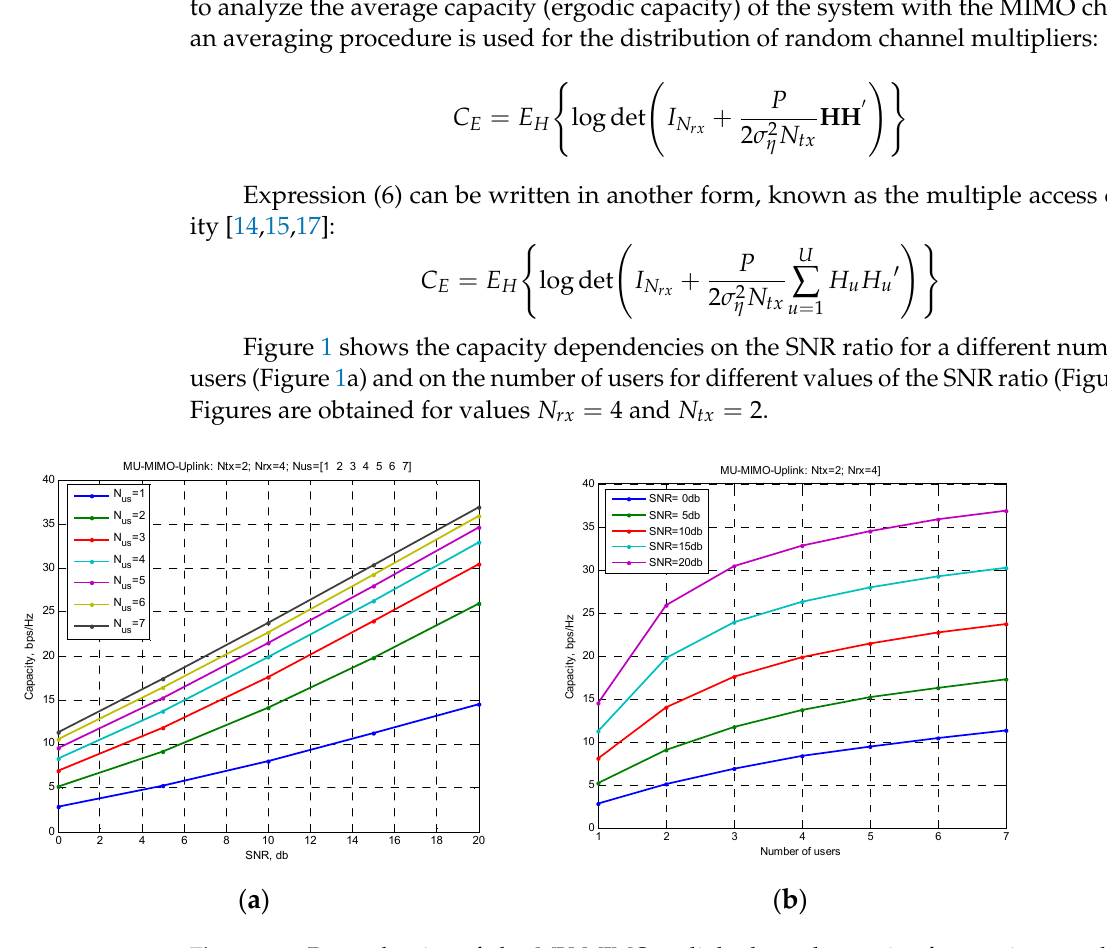
Figure 1. Dependencies of the MU-MIMO uplink channel capacity for continuous channel: ( a ) capacity dependencies on the SNR ratio for a different number of users, ( b ) capacity depen- dencies on the number of users for different values of the SNR